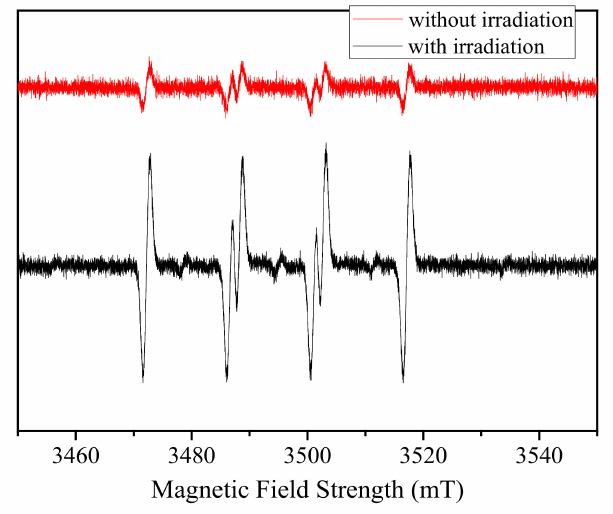
Figure 7. ESR spectra of reaction solutions at pH 7.0. Conditions: [S(IV)] 0 = 1.0 mM, [Fe(III)] 0 = 0.1 mM. [DMPO] = 1 g L − 1 .